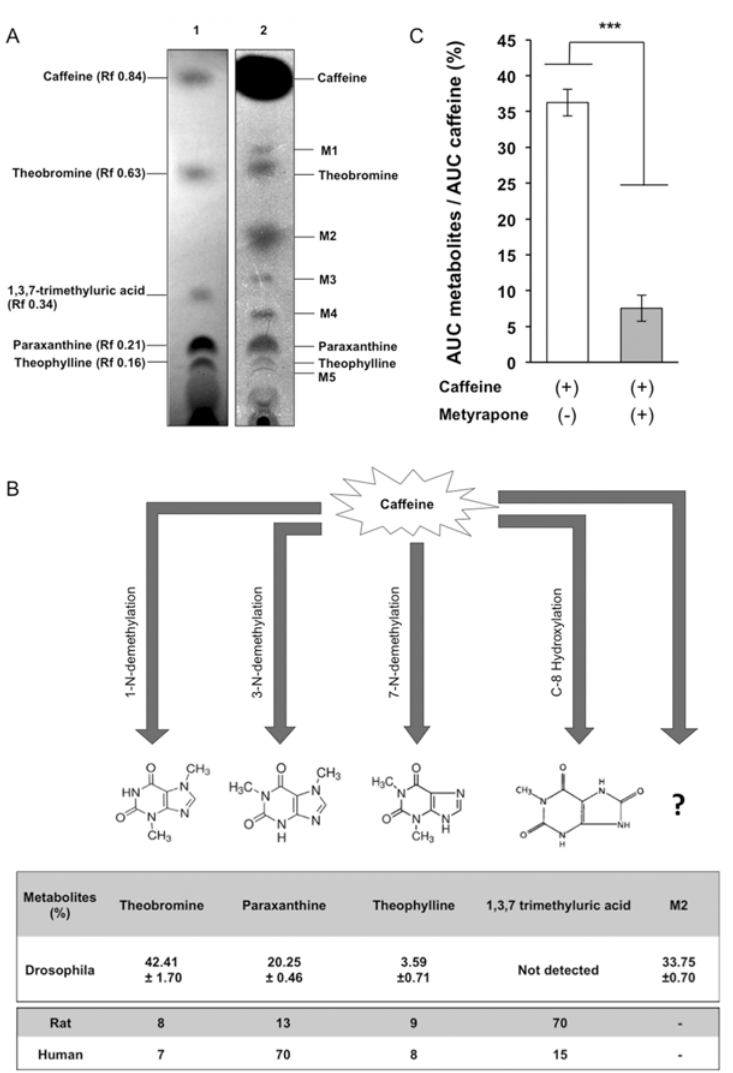
Fig 1. Caffeine metabolism in Drosophila melanogaster and the influence of cytochrome P450 inhibitor. A- Separation of non-radiolabeled standards of caffeine and metabolites (lane 1) with a homogenate of wild-type four-days-old Drosophila male flies (w 1118 ) exposed with radiolabeled caffeine for 2 hours (lane 2) on thin layer chromatography. B- The total amount of caffeine derived metabolites was strongly decreased in the body of male flies after exposure to caffeine mixed with metyrapone (+), as compared to control food (-). The amounts were evaluated by densitometry which is based on the comparison of the areas under the curve (AUC) for both metabolites and caffeine. Bars indicate the mean values ( ± s.e.m.). Significant differences are indicated by asterisks (Student ’ s t-test *** p < 0.001; n = 3). C- Interspecific variation for the level of major caffeine metabolites. The proportions of theobromine, paraxanthine and theophylline and of the unidentified M2 metabolite detected in fly bodies after caffeine exposure (18mM) are indicated as the mean ( ± s.e.m.; n = 4). In Drosophila melanogaster , these amounts were evaluated by measuring the relative intensity of the radiolabelled signal associated with each metabolite after thin layer chromatography separation. The proportion of these compounds detected in Drosophila melanogaster was compared with that reported for Rattus norvegicus and Homo sapiens [25 – 28].